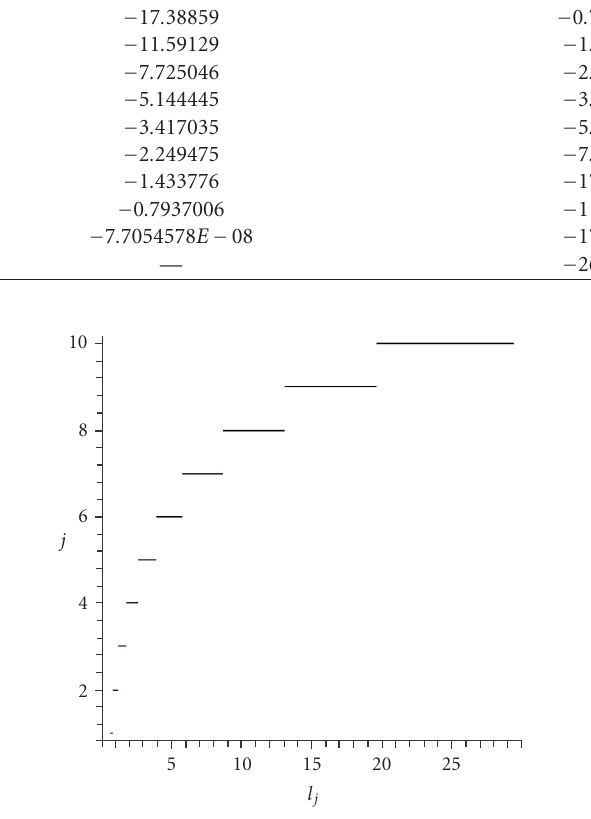
Figure 5.2. The successive gaps of the sequence generated by formula